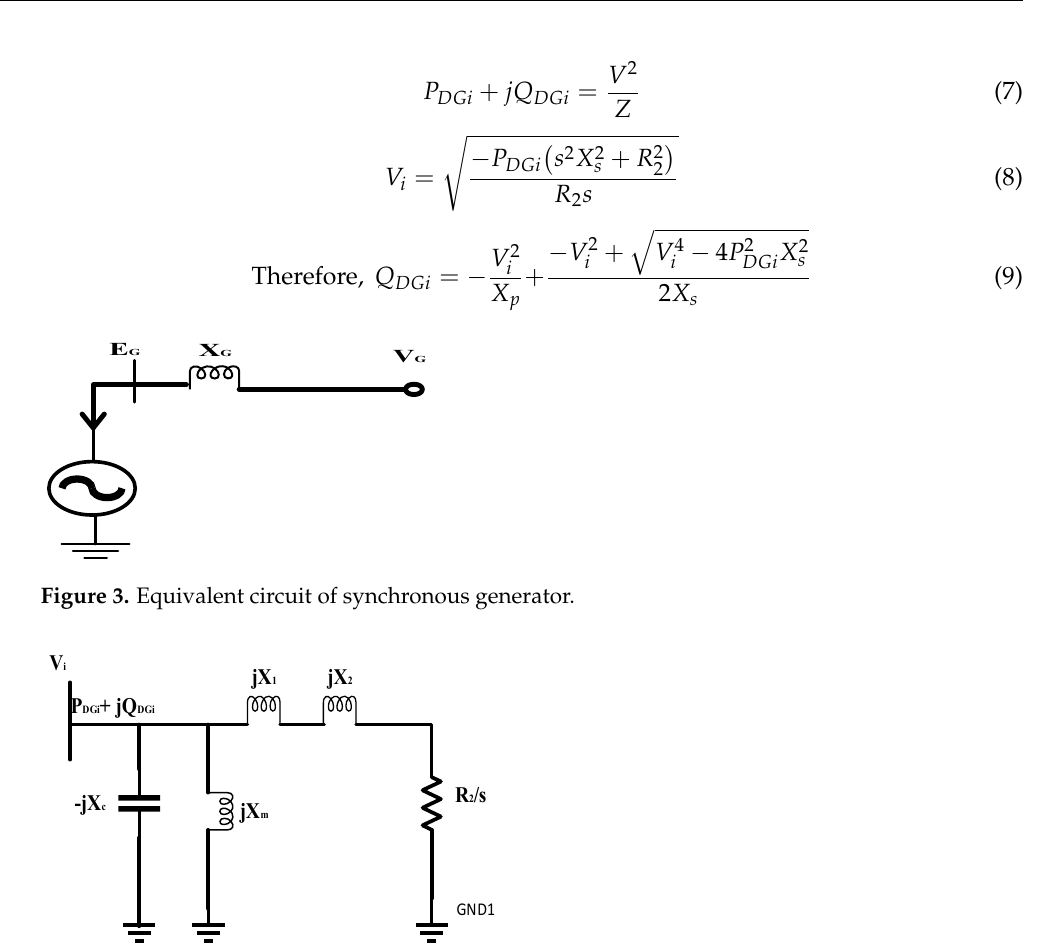
Figure 4. Equivalent circuit of induction generator.